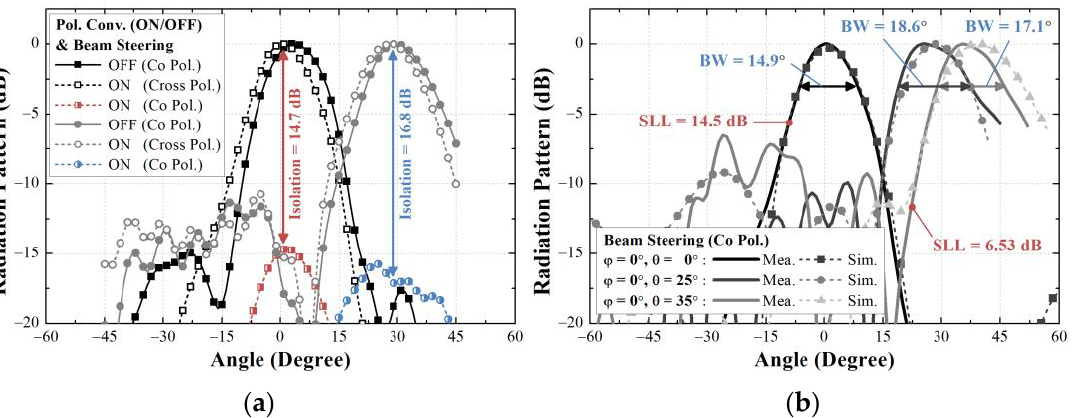
Figure 7. Measured radiation pattern of multi-functional transmitarray. Results of: ( a ) scan angle in horizontal plane; ( b ) scan angle in diagonal planes with the state changes of polarization.